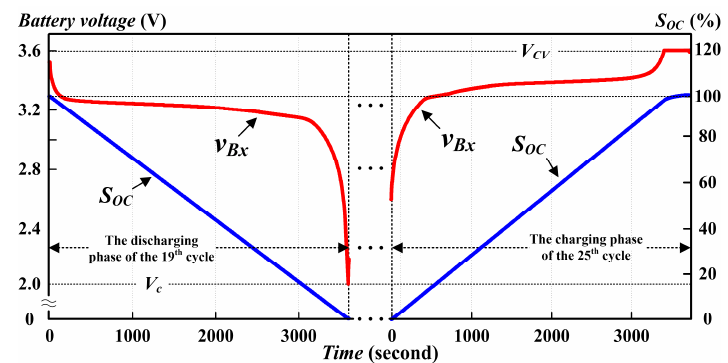
Figure 6. Battery voltage and SOC curves during regular calibrations.